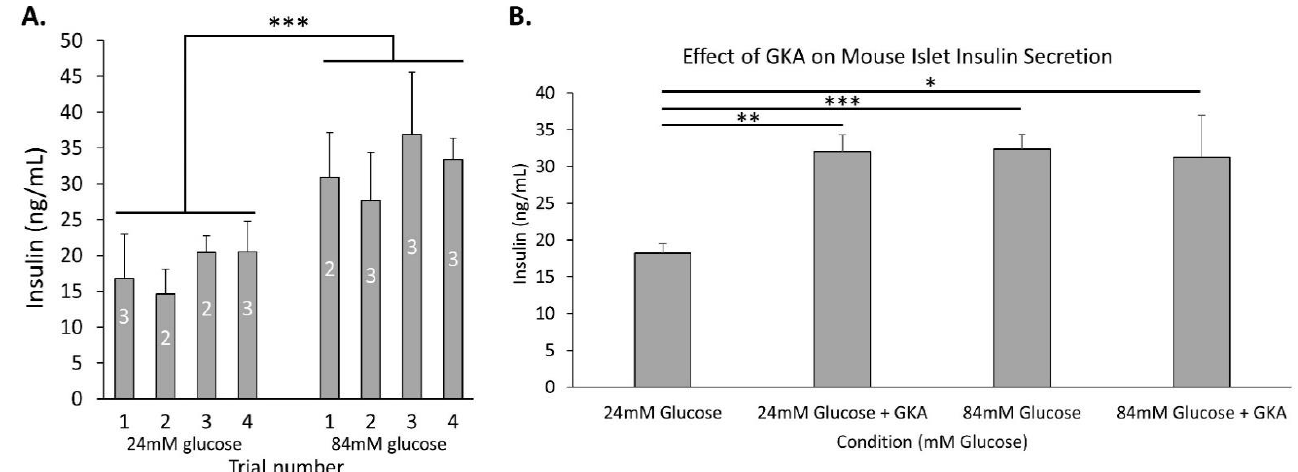
Figure 4. Insulin secretion in extremely high glucose is associated with increased glycolysis. ( A ) Insulin secretion was measured after 1h incubation in 24 mM glucose (regarded as maximal) and 84 mM glucose (regarded as extreme) shown for four separate trials with N = 2–3 replicates to demonstrate consistency of the difference in insulin secretion from trial to trial. Combining these trials, the data were significantly different with a p -value of <0.001 by two-tailed T-test between 24 and 84 mM glucose. ( B ) Mouse islets were placed in wells containing modified KRB with 24 mM or 84 mM glucose ± mannitol balanced to 84 mM total for 1 h with or without 500 nM GKA. The GKA increased insulin secretion significantly in 24 mM glucose ( p < 0.01) but failed to do so in 84 mM glucose. All data are presented as ± SEM. N = 3–11 replicates. * p < 0.05, ** p < 0.01, *** p <